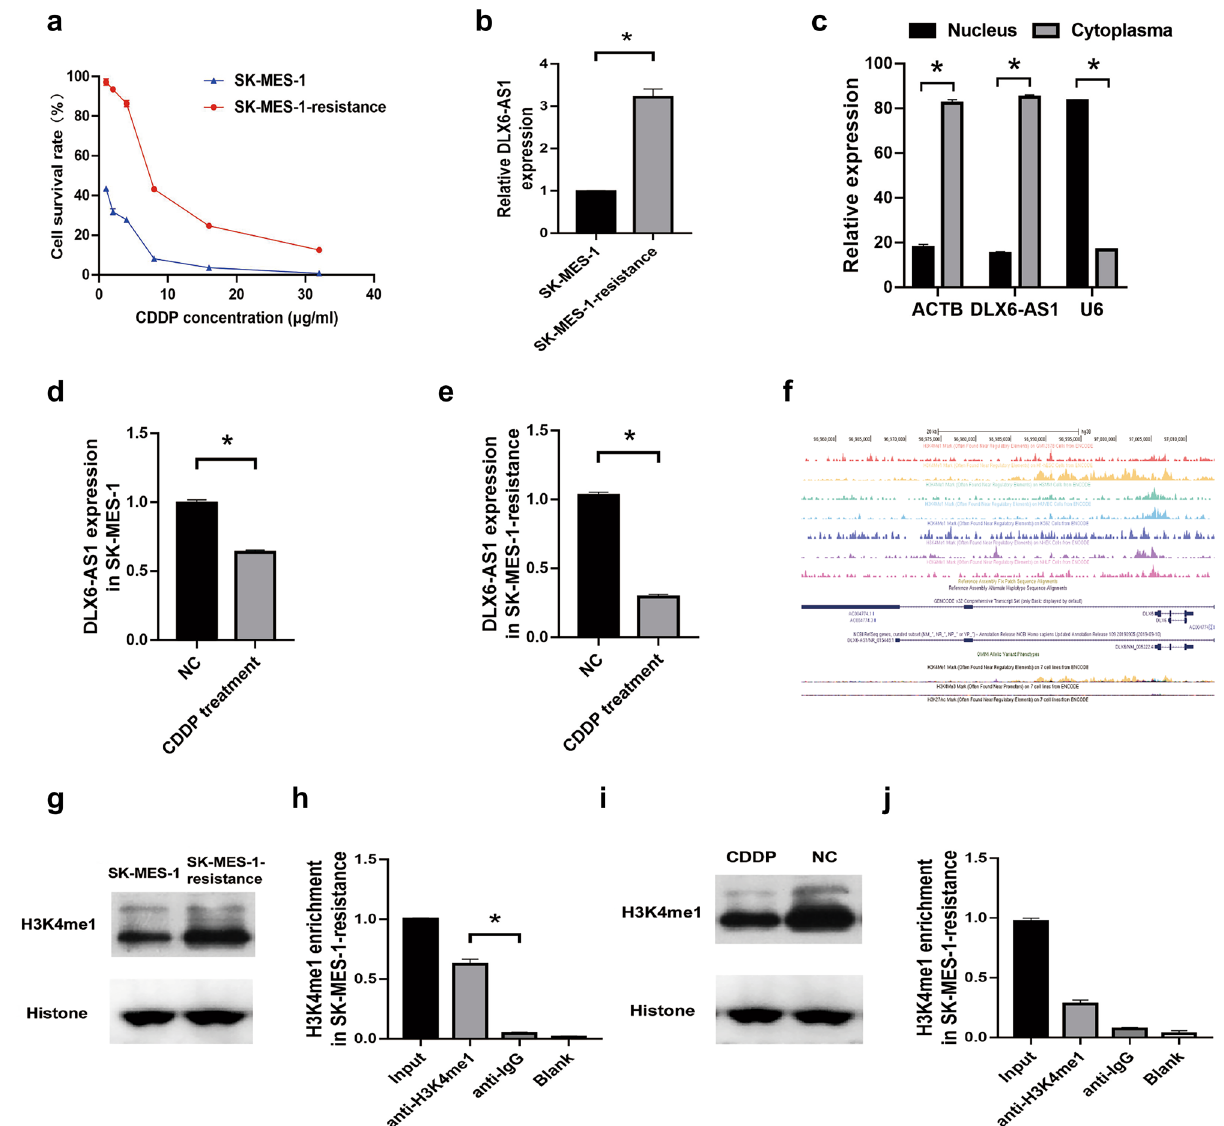
Figure 4. DLX6-AS1 was induced by H3K4me1 in cisplatin resistant LUSC cells. ( a ) The IC50 of CDDP in SK-MES-1 or SK-MES-1-resistance cell lines was detected by conducting CCK-8 assay. ( b ) qRT-PCR analysis for the relative expression of DLX6-AS1 in SK-MES-1 or SK-MES-1-resistance cell lines. ( c ) qRT-PCR analysis for the relative expression of DLX6-AS1 in the cytoplasm or nucleus of SK-MES-1-resistance cell line. ( d,e ) qRT-PCR analysis for the relative expression of DLX6-AS1 in SK-MES-1 ( d ) or SK-MES-1-resistance ( e ) cell lines treated with or without CDDP. ( f ) The binding relationship between the promoter region of DLX6-AS1 and H3K4me1 was predicated by UCSC. ( g ) The relative expression of H3K4me1 in SK-MES-1 or SK-MES-1- resistance cells was estimated by Western blot analysis. ( h ) ChIP assay analysis for the enrichment of H3K4me1 in SK-MES-1-resistance cells. ( i ) The relative expression of H3K4me1 in SK-MES-1-resistance cells treated with CDDP was estimated by Western blot analysis. ( j ) ChIP assay analysis for the enrichment of H3K4me1 in SK-MES-1-resistance cells treated with CDDP. * P <